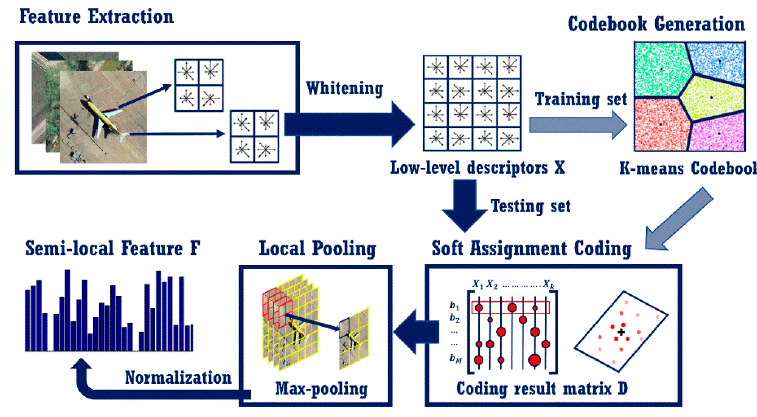
Figure 2. The pipeline of the BOVW coding layer.